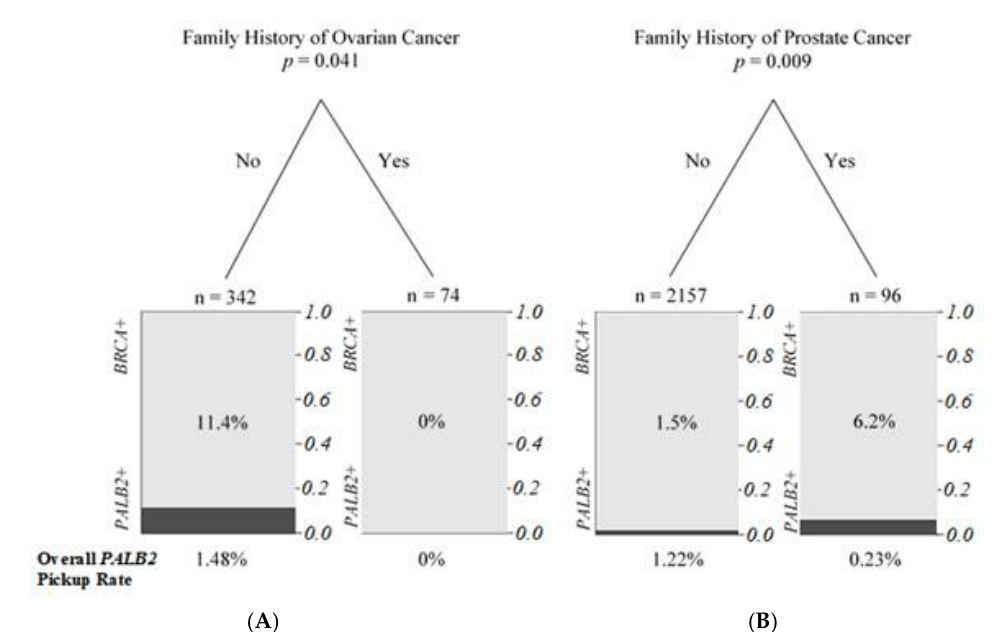
Figure 3. Regression tree for prediction of probability to find PALB2 pathogenic mutation carriers from BRCA1 carriers.